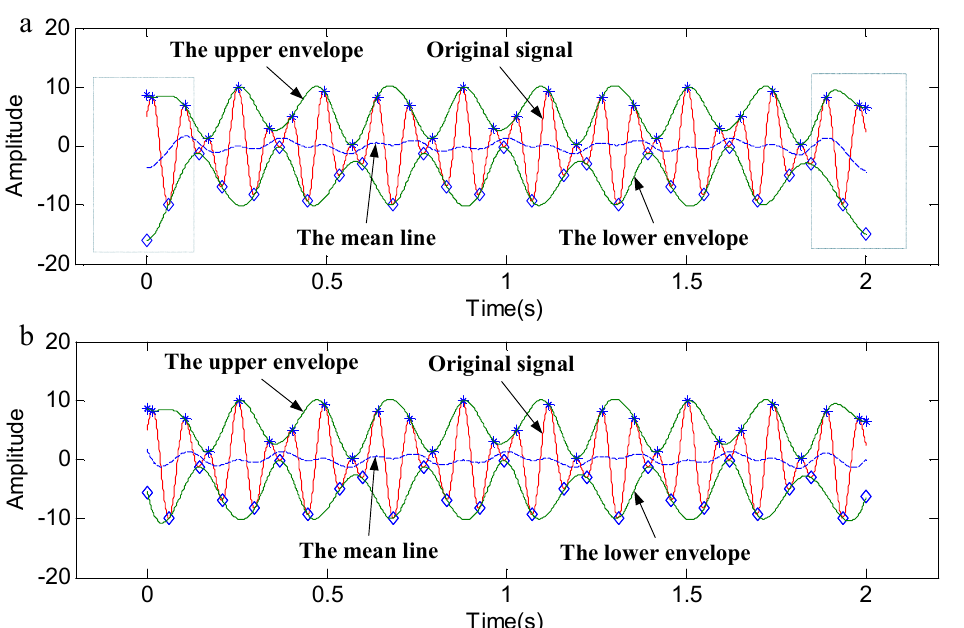
Figure 7. The envelopes. ( a ) The envelopes obtained by Yang’s method; ( b ) The envelopes obtained by the local linear extrapolation method.